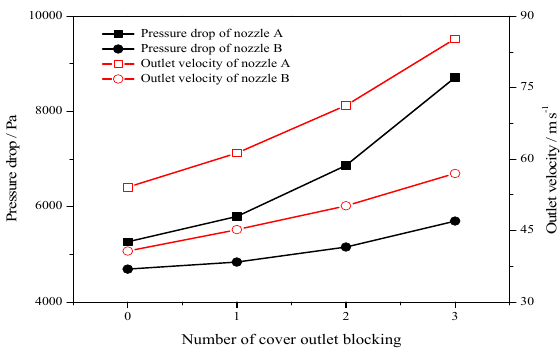
Figure 11. Resistance characteristics of nozzle A and nozzle B after blocking.